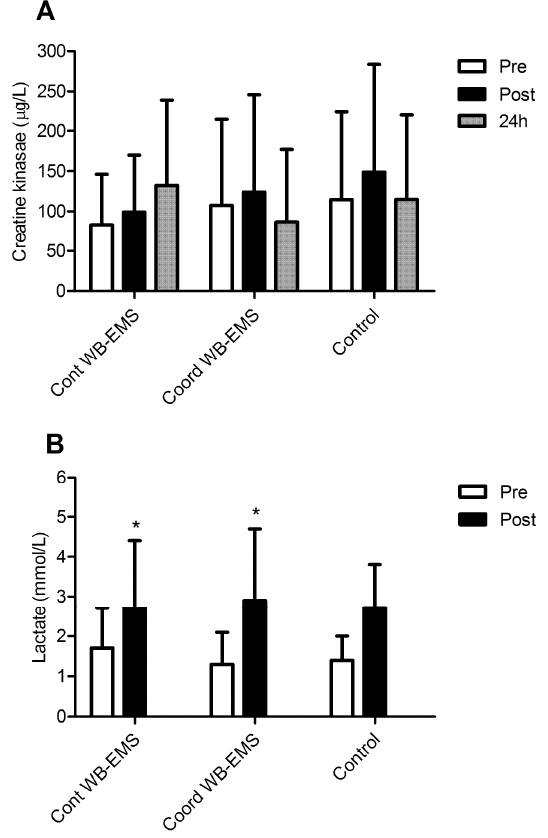
Figure 1. ( A ): creatine kinase blood levels before, after and the day after the strength exercise session with a continuous stimulus (Cont WB-EM), coordinated stimulus with concentric and eccentric phases (Coord WB-EMS) and without whole-body electromyostimulation (Control). ( B ): lactate blood levels before and after the strength exercise session with the continuous stimulus (Cont WB-EM), coordinated stimulus with concentric and eccentric phases (Coord WB-EMS) and without whole-body electromyostimulation (Control). * Significantly different than the pre-exercise in all trials ( p < 0.05).